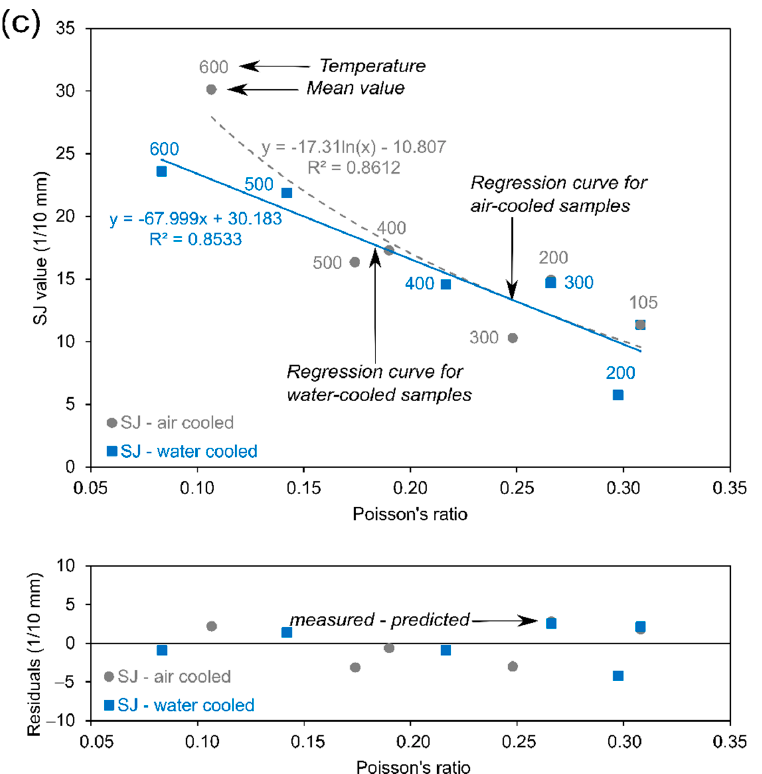
Figure 10. Correlations between variation of SJ and: ( a ) UCS; ( b ) elastic modulus; and ( c ) Poisson’s ratio for air- and water-cooled samples.